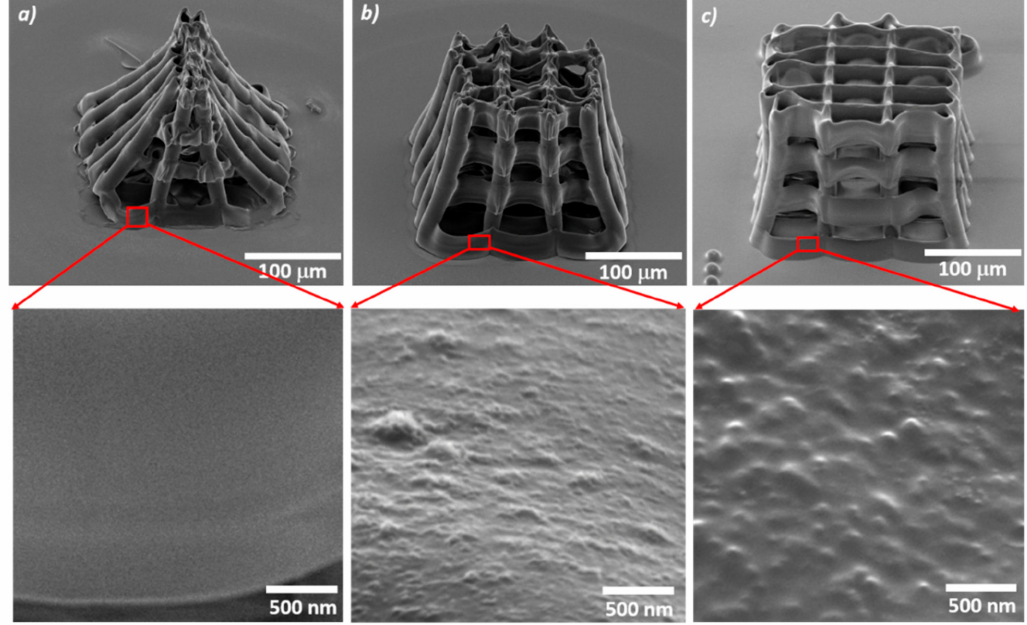
Figure 2. Scanning electron micrographs of sca ff olds with magnetic nanoparticles (MNPs)